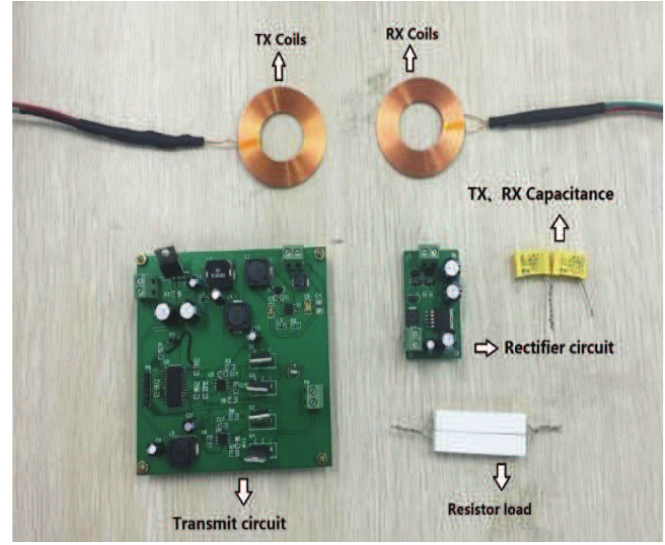
Figure 8. The test device of the WPT